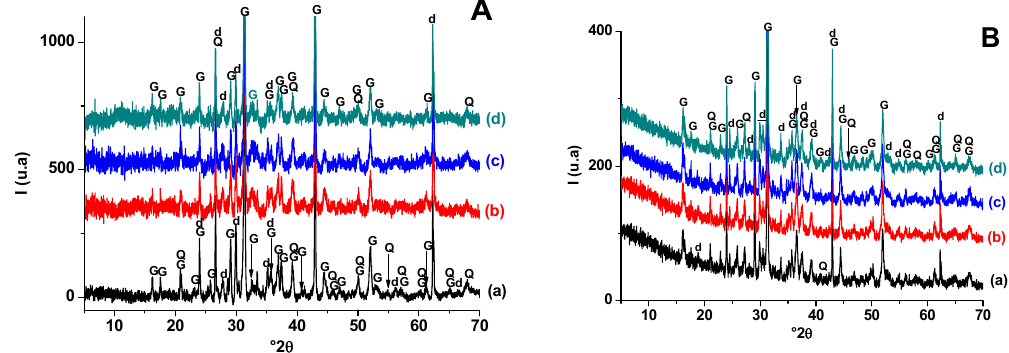
Figure 3. X-ray diffraction patterns of blends heated at 900 °C ( A ) and 1100 °C ( B ). (a) SA; (b) SA-SC (5 wt. % of SC); (c) SA-SC (10 wt. % of SC); (d) SA-SC (20 wt. % of SC). G: Gehlenite (PDF # 72-2128); Q: Quartz (PDF # 79-1911); d: diopside (PDF # 75-0945).